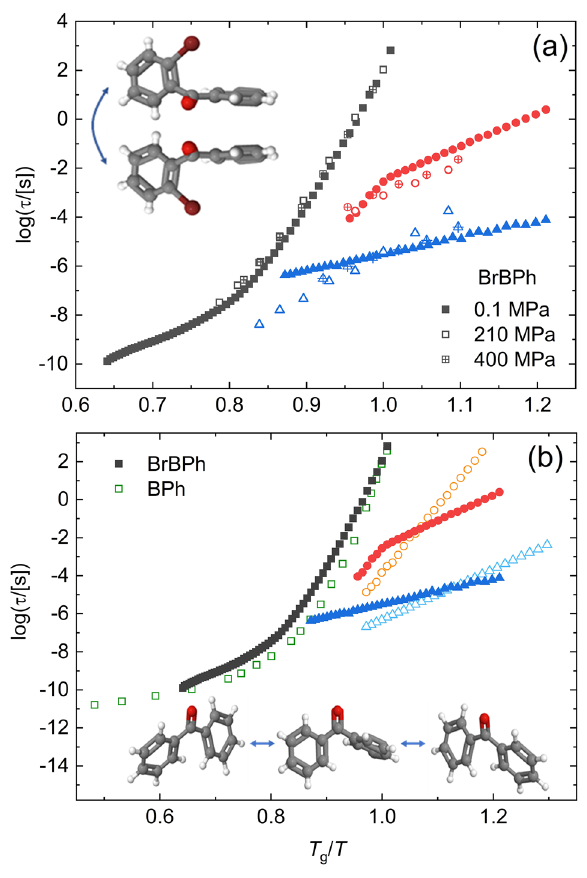
Figure 6. ( a ) Angell plot of all dielectric relaxation times of BrBPh at various ( T , P ) conditions (same data as in Fig. 4). Inset: proposed conformational change of the BrBPh molecules, corresponding to the γ relaxation. ( b ) Ambient-pressure comparative Angell plots of BrBPh and BPh. Inset: proposed pathway of the conformational change of the BPh molecules, corresponding to the γ relaxation of this